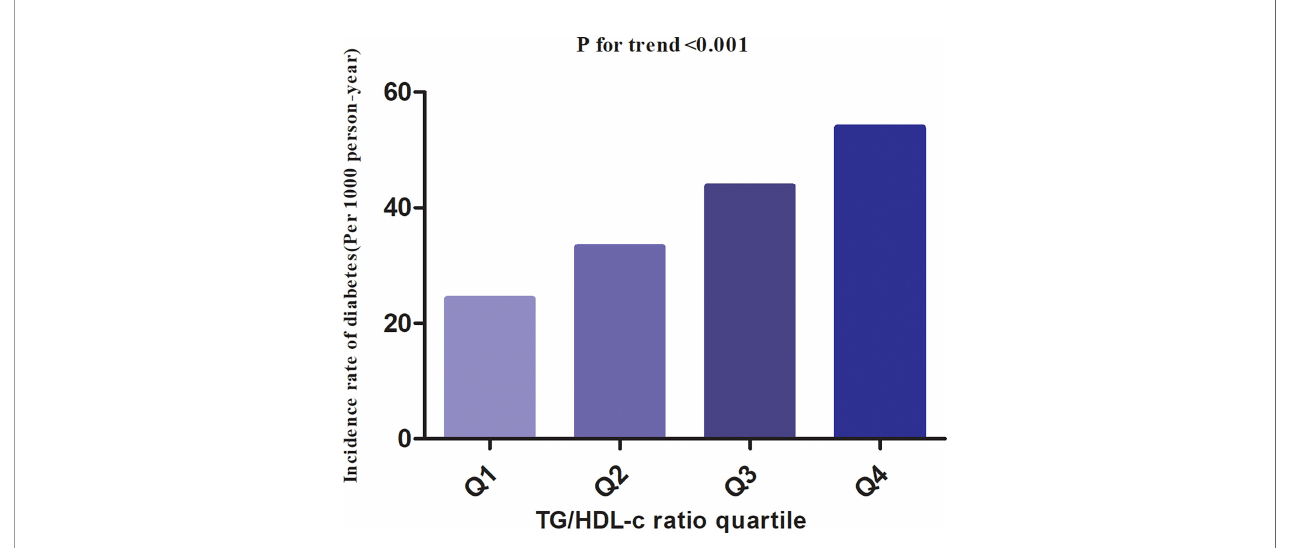
FIGURE 3 | The incidence rate for diabetes(Per 1000 person-year) according to the quartiles of TG/HDL-c ratio. Participants with the highest TG/HDL-c ratio (Q4) had higher diabetes incidence rates than those with the lowest TG/HDL-c ratio (Q1) (P < 0.001 for trend).